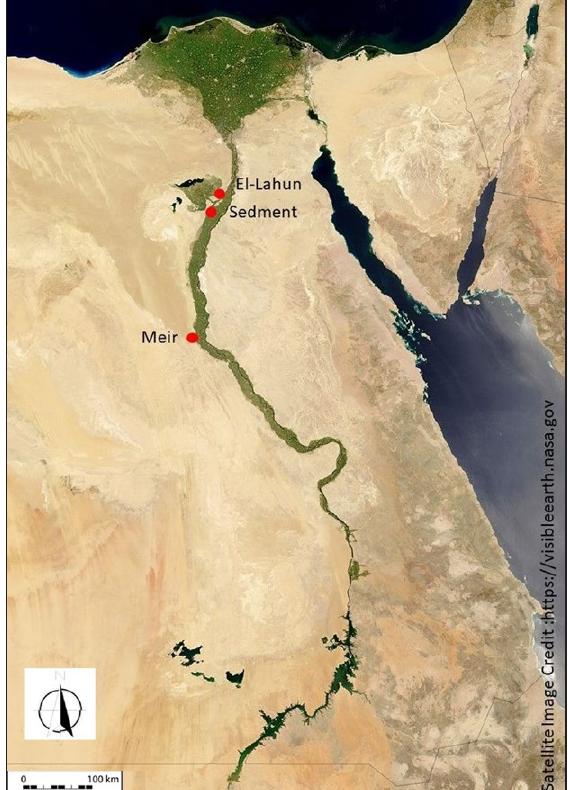
Figure 1: Localisation of wooden models provenances.